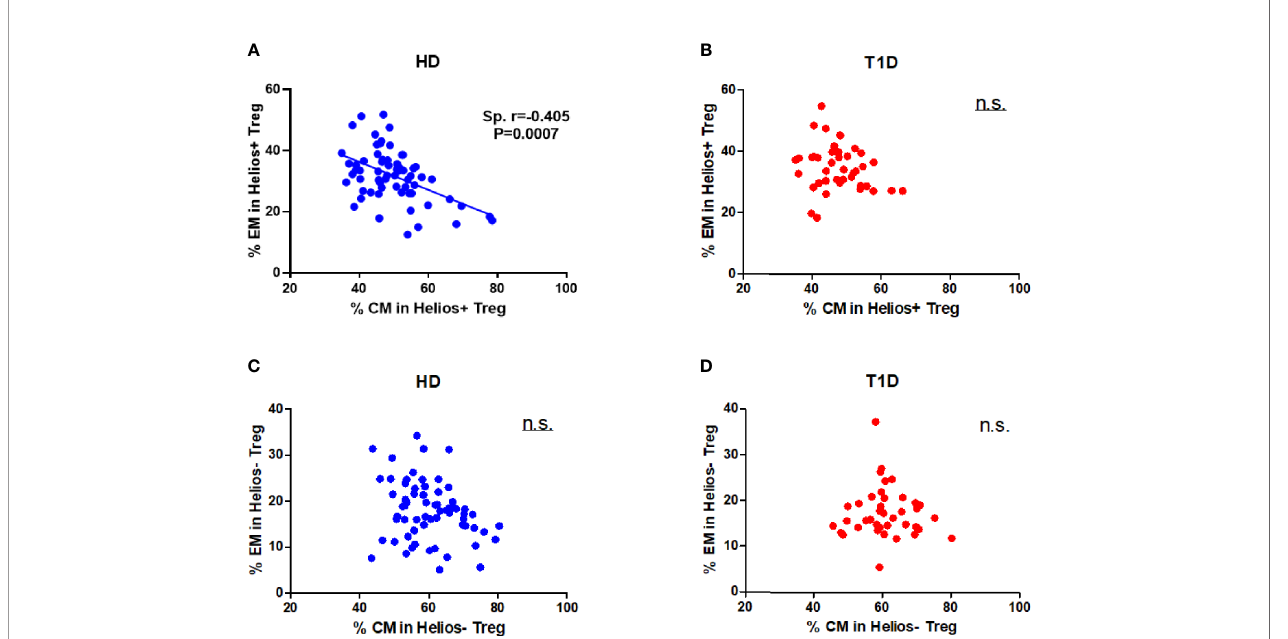
FIGURE 4 | A distinct effector/memory differentiation path occurs in Helios + Tregs from T1D individuals. Correlation analysis between the percentages of CM and EM Treg subsets (Helios + or Helios − ) from healthy donors (HD) (A, C) and T1D (B, D) individuals. Spearman rank test was used for the evaluation of the correlation. The results were from 68 healthy controls and 40 autoantibody-positive T1D individuals. Samples from T1D individuals and healthy controls were randomly divided to each independent experiment. One biological sample (from the same healthy donor and drawn at the same time) was performed as control for the experimental reproducibility. Spearman correlation was performed for these correlations. A p value <0.05 was considered as signi fi cant. ns, not signi fi